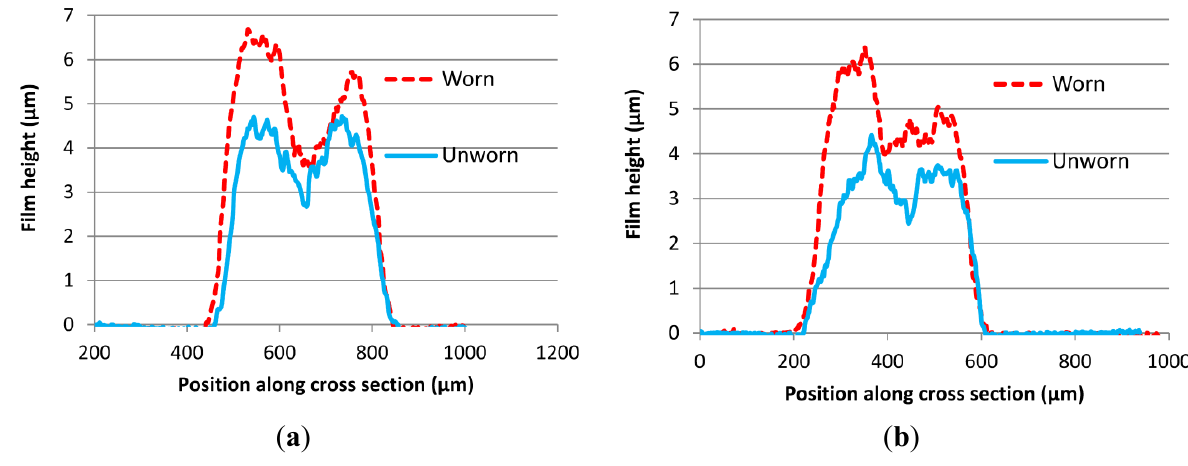
Figure 12. Sample images of variation in ink deposition (cross-section) as a result of squeegee wear at different orientations: ( a ) Parallel to print direction (90° to squeegee); ( b ) 90° to print direction (parallel to squeegee); using 1200 grit abrasive, Squeegee 4. Note this effect varies depending on squeegee/abrasive types.